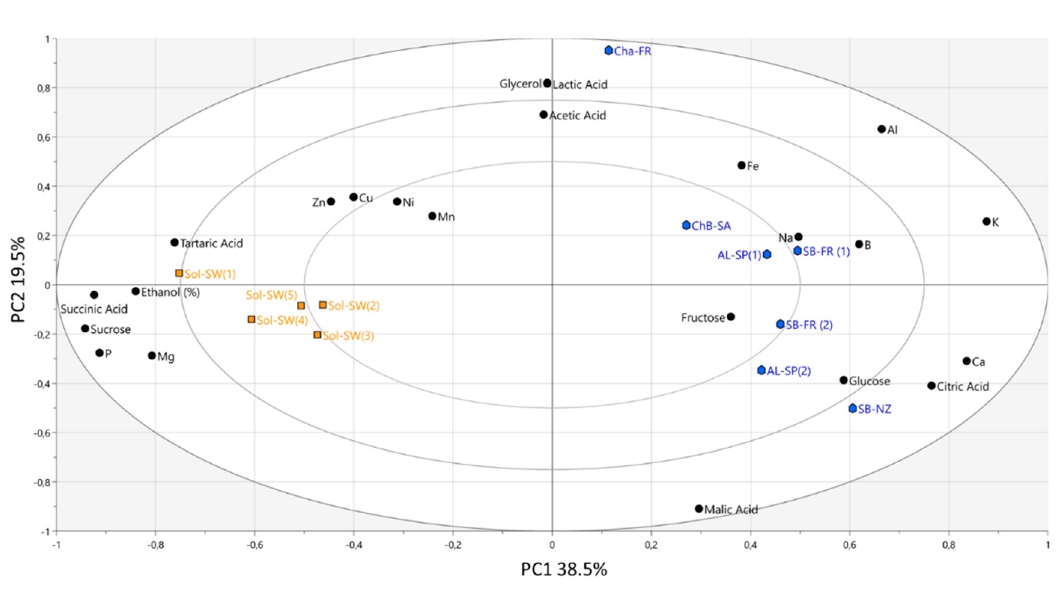
Figure 6. PCA biplot representing the distribution of the wines according to the non-volatile data. Solaris wines are colored in orange and non-Solaris wines are colored in blue.